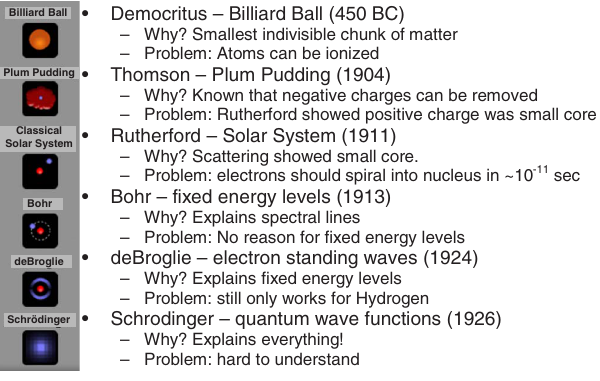
FIG. 1. (cid:1) Color (cid:2) Models of the atom discussed